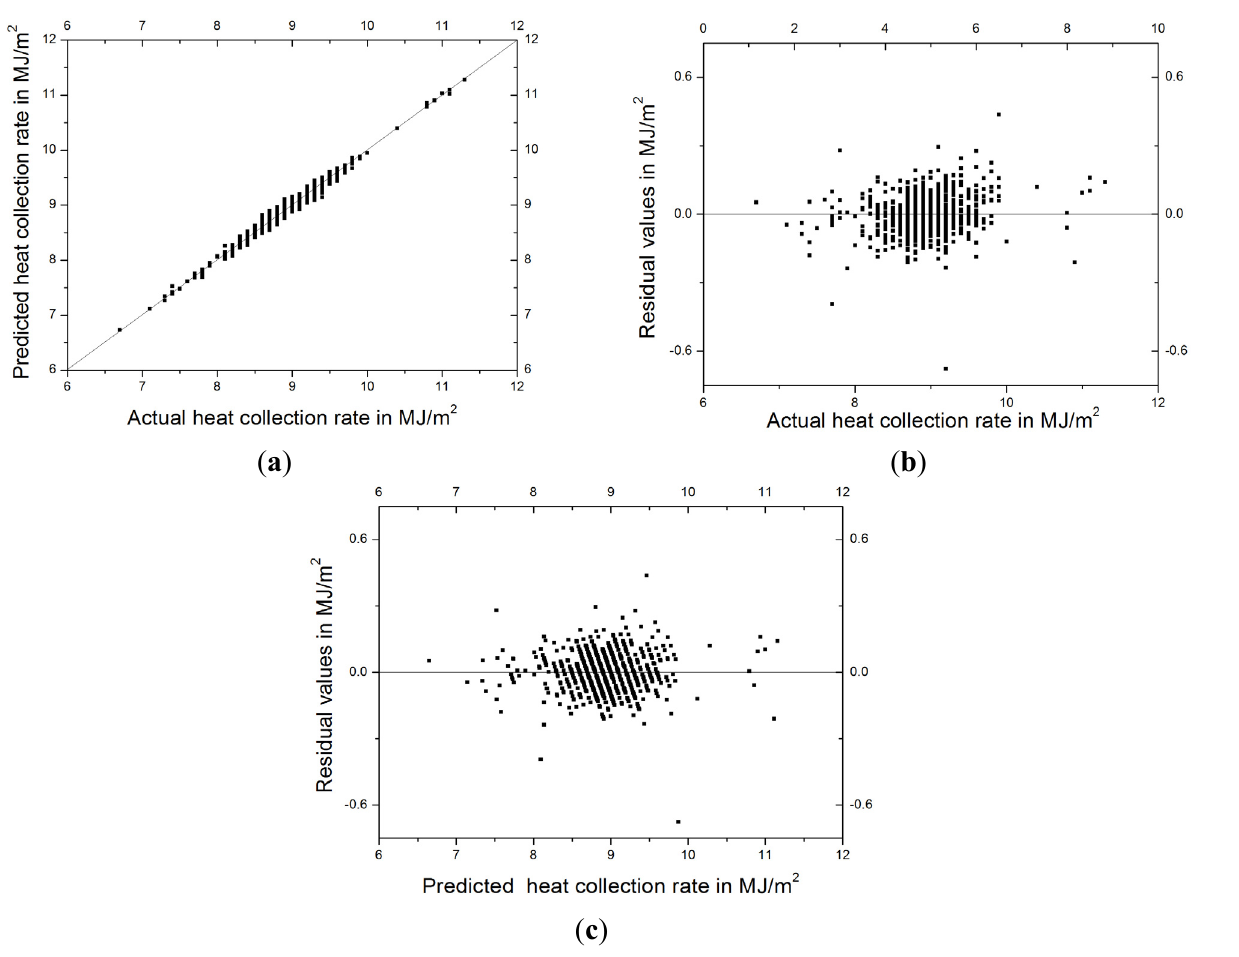
Figure 6. Training results of 778 samples using the MLFN-3 for the prediction of heat collection rate. ( a ) Predicted values versus actual values; ( b ) residual values versus actual values; ( c ) residual values versus predicted